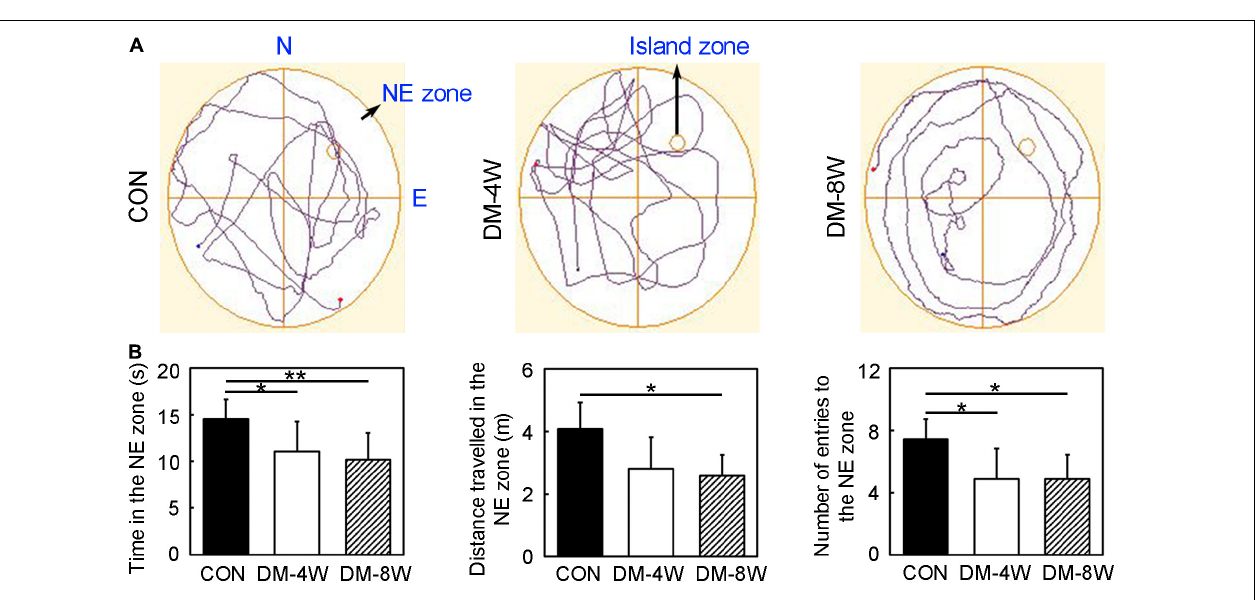
FIGURE 2 | Learning and cognition behavior attenuated in diabetic mice. (A) The track plot showed the mouse trace of the control, DM-4W and DM-8W groups in the probe test. (B) Bar graphs showed the time in the NE zone, the distance traveled in the NE zone and number of entries to the NE zone. The island zone was located in the NE zone. Data are mean ± SD , n = 8 per group, * p < 0.05, DM-4W or DM-8W vs. control; ** p < 0.01, DM-8W vs.